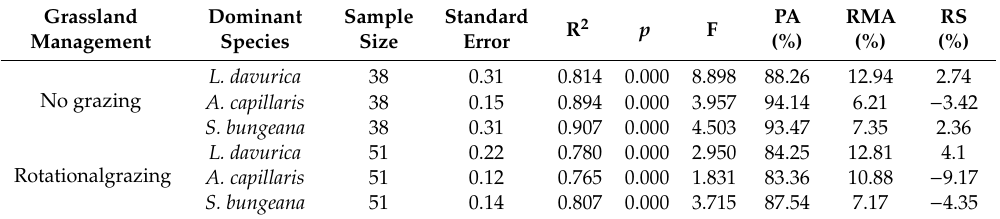
Table 3. Accuracy test of predictive equations under two managements of grassland. Grassland